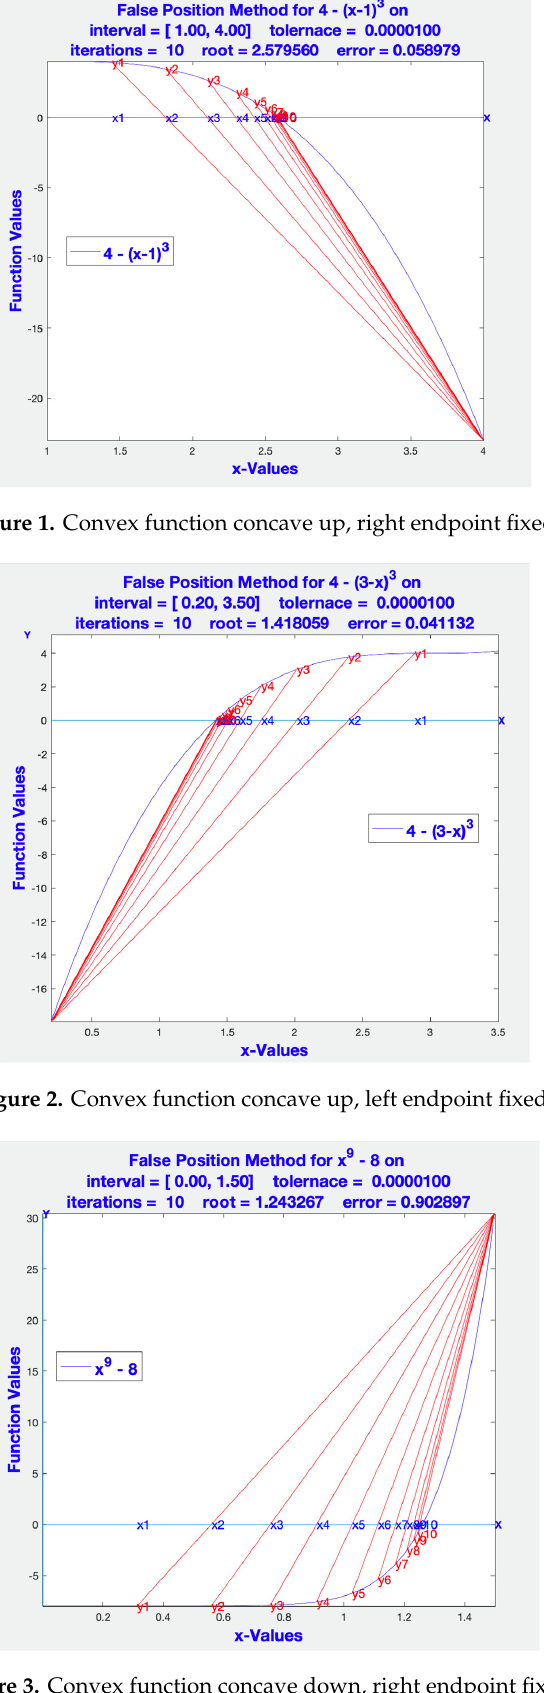
Figure 4. Convex function concave down, left endpoint fixed. 2.3. Newton–Raphson Method Newton–Raphson is also called a fixed-point iteration method. This method requires that the function be differentiable. If the function f(x) is differentiable on the domain of the function, and r 0 is the initial guess, then the first approximation r 1 is obtained by intersection of the tangent at (r 0 , f(r 0 )) with the x-axis, and is defined by